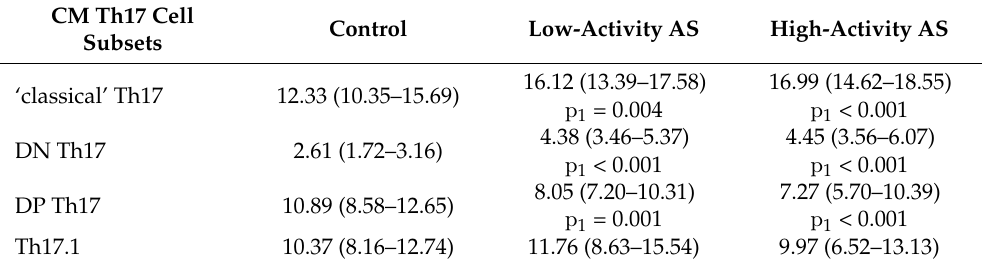
Table 3. Peripheral blood CM Th17-cell subset composition (%) in activity-driven AS patients ( Ме (IQR)).